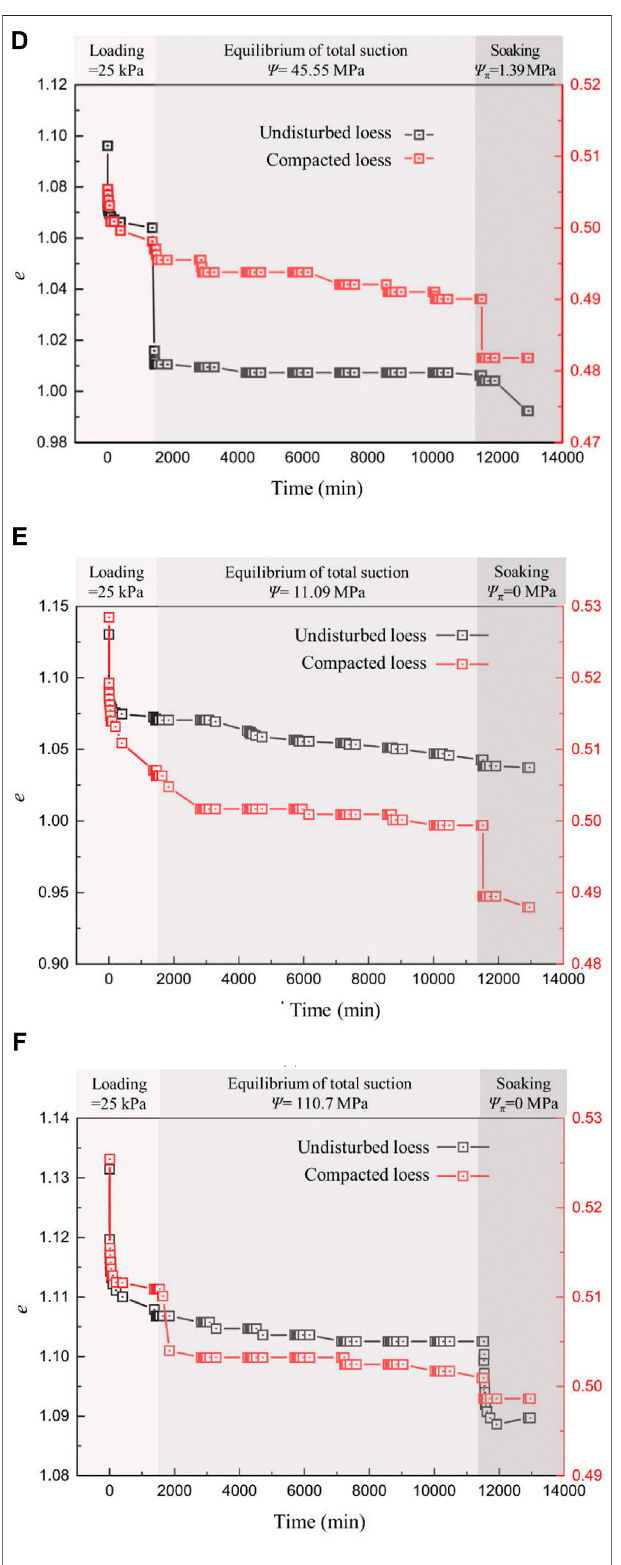
FIGURE 8 | The compression index C c and swelling index C s versus Ψ - Ψ